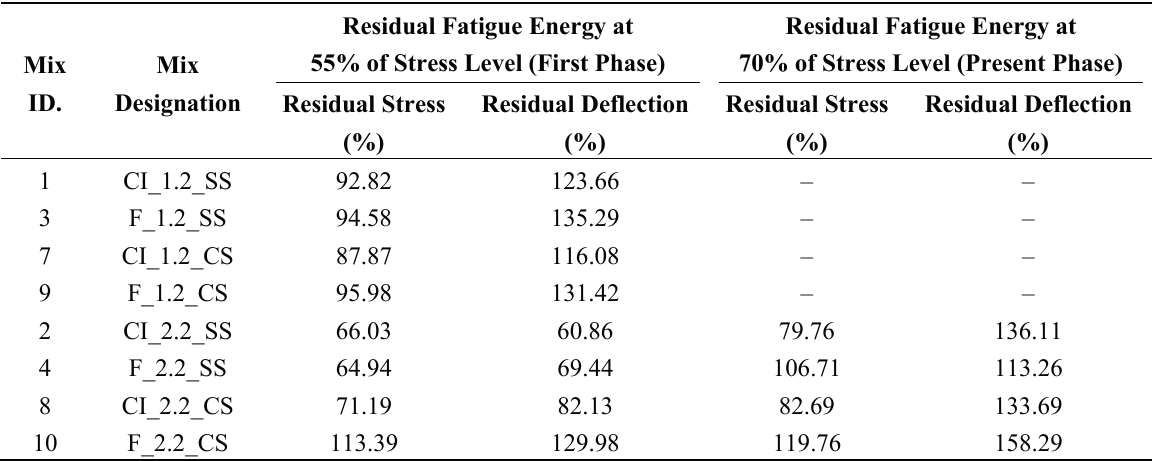
Table 7. Comparison between second and present Fatigue strength and deflection